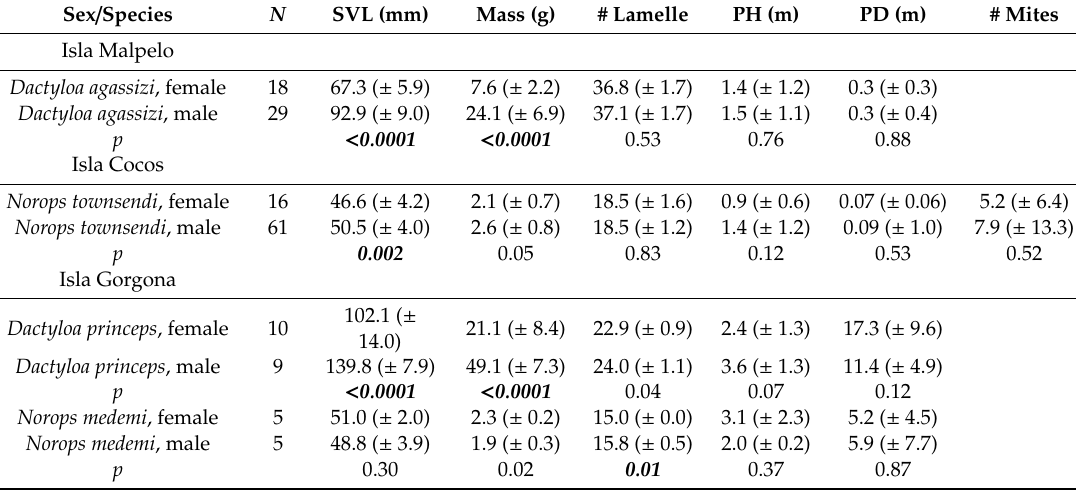
Table 2. Average morphological measurements by sex for four species of Pacific Island anoles. (SVL = snout-vent length, # lamelle = # of lamellar rows). P -values from pairwise t-tests between the sexes are listed below the means. Standard deviation is included for each mean value in parentheses. Significant values after Bonferroni correction are bolded and italicized.